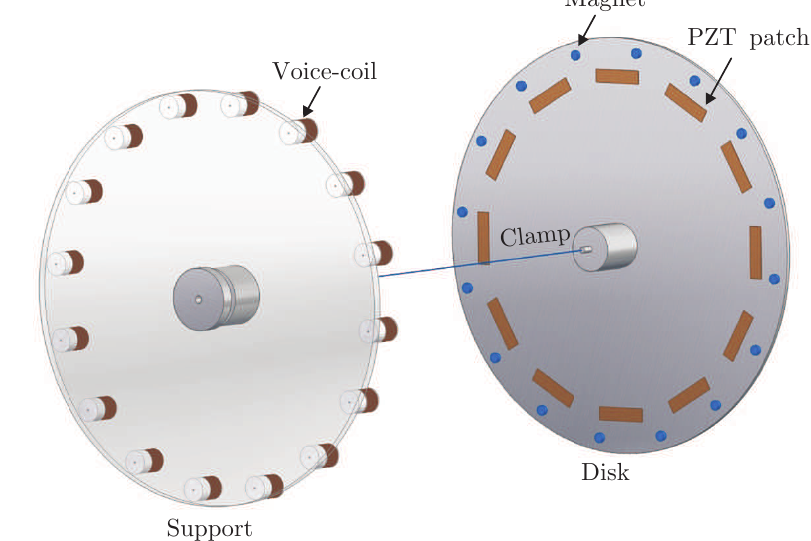
Figure 5. CAD view of the experimental setup with 12 PZT patches. Two different electrical connections are investigated according to Figure 4: ( i ) 12 independent loops and ( ii ) two parallel loops. The voice coil and magnets are intended for non-contact excitation; they are connected to 16 independent current amplifiers.